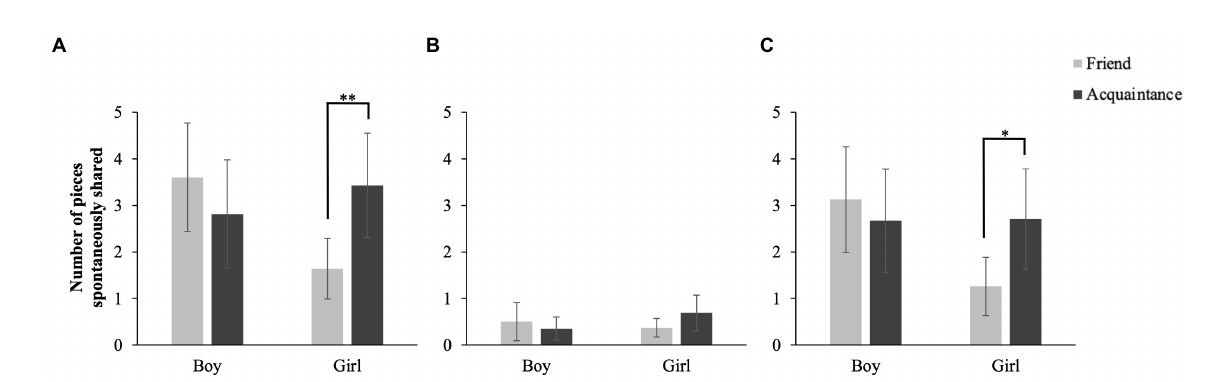
FIGURE 2 Interaction between number of pieces of spontaneously food shared and sex. (A) Total number of pieces of food shared spontaneously. (B) Number of pieces of preferred food shared spontaneously. (C) Number of pieces of non-preferred food shared spontaneously. Error bars represent 95% confidence intervals. * p <0.05, ** p